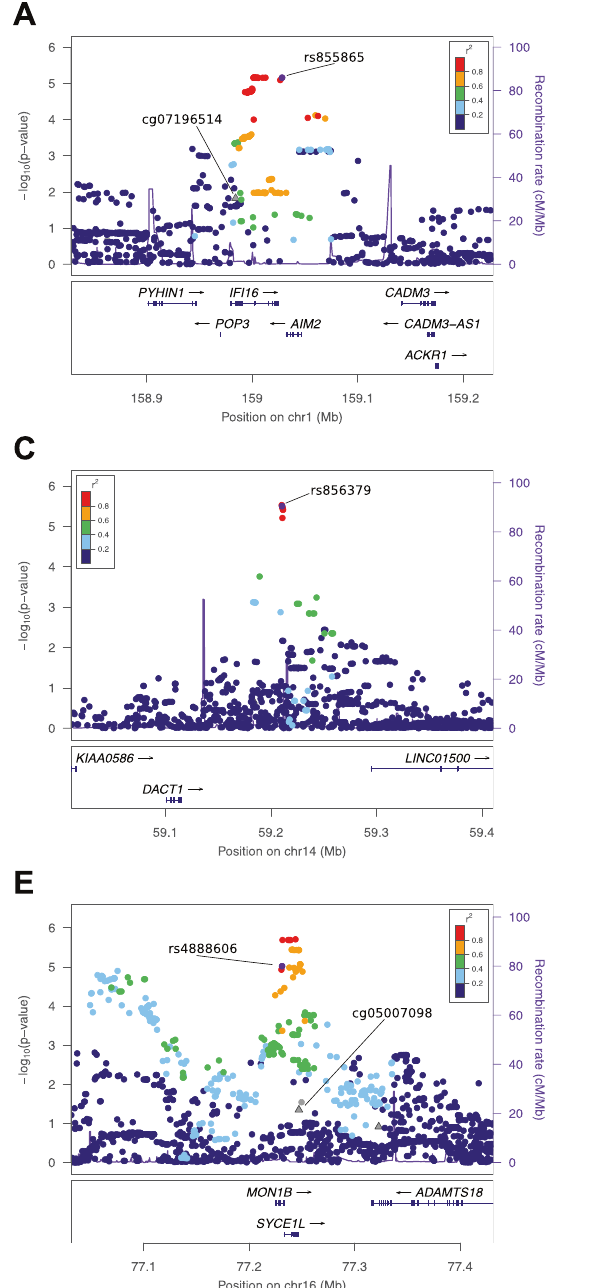
Fig. 2 Locus zoom plots for most signi fi cant fi ndings. Figure 2 shows association results for the top loci. p -Values displayed are for CFSRS and are for the test for which the top SNP was observed. Circles show p -values for SNP associations and triangles show p -values for methylation associations (speci fi cally those for which the top SNP is an meQTL). The plot shows the top SNP for each region ±200 kb. a IFI16 region. rs855865 was associated with NSW in CFSRS ( p = 7 × 10 − 6 ) and with vocabulary (WISC-V) in ALSPAC ( p = 0.01). This region also includes an meQTL (rs12124059, p = 4 × 10 − 8 ) for methylation marker cg07196514, and this methylation marker (cg07196514) was also associated with NSW ( p = 0.018). b NFKBIA region. rs57645874 was associated with Elision in CFSRS ( p = 1 × 10 − 6 ) and with reading accuracy (NARA-A) in ALSPAC ( p = 0.02). This region also contains an meQTL, rs4981288, for cg07166546 ( p = 2 × 10 − 50 ), and this methylation marker was associated with Elision ( p = 3 × 10 − 5 ), TWS ( p = 0.0005) and WRMT-ID ( p = 0.002). c DACT1 region. rs856379 was associated with MSW in CFSRS ( p = 3 × 10 − 6 ) and with nonword reading (ALSPACread) in ALSPAC ( p = 0.036). This SNP is an meQTL for methylation marker cg13972423 (p = 3 × 10 − 5 ). d SETD3 region rs1257267 was associated with WRMT-AT in CFSRS ( p = 6.58 × 10 − 6 ) and with nonsense word repetition (CNrep5) in ALSPAC ( p = 0.05). While only 1 SNP replicated between CFSRS and ALSPAC, 14 additional SNPs showed association in CFSRS at p < 10 − 5 . This SNP (rs1257267) is an meQTL for cg18949721 ( p = 4 × 10 − 12 ), and methylation marker cg18949721 was also associated with WRMT-AT ( p = 0.003). e MON1B region. rs4888606 was associated with MSW in CFSRS ( p = 9 × 10 − 6 ) and with nonword reading (ALSPACread) in ALSPAC ( p = 0.046). While only 1 SNP replicated between CFSRS and ALSPAC, 18 additional SNPs showed association in